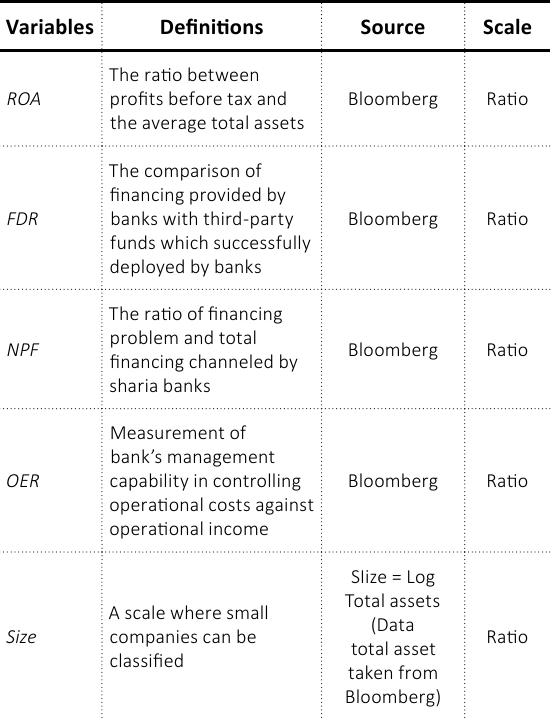
Table 3. Variable